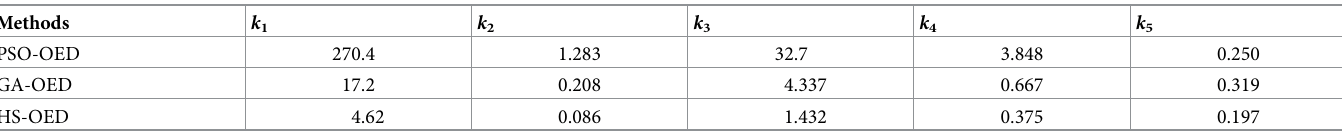
obtained by HS-OED algorithm and GA,PSO-based OED methods. These indexes are i